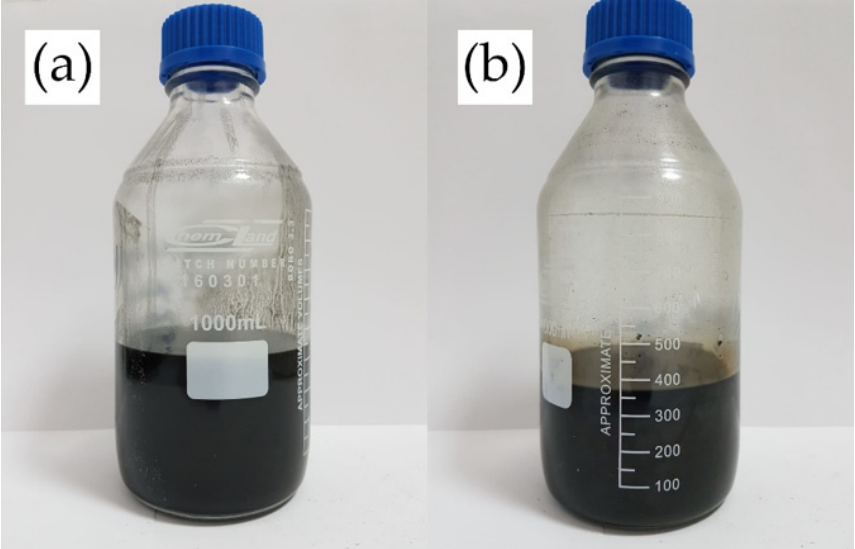
Figure 1. Appearance of eco-polyols: ( a ) PLA0.4DEG; ( b ) PLA0.3DEG.